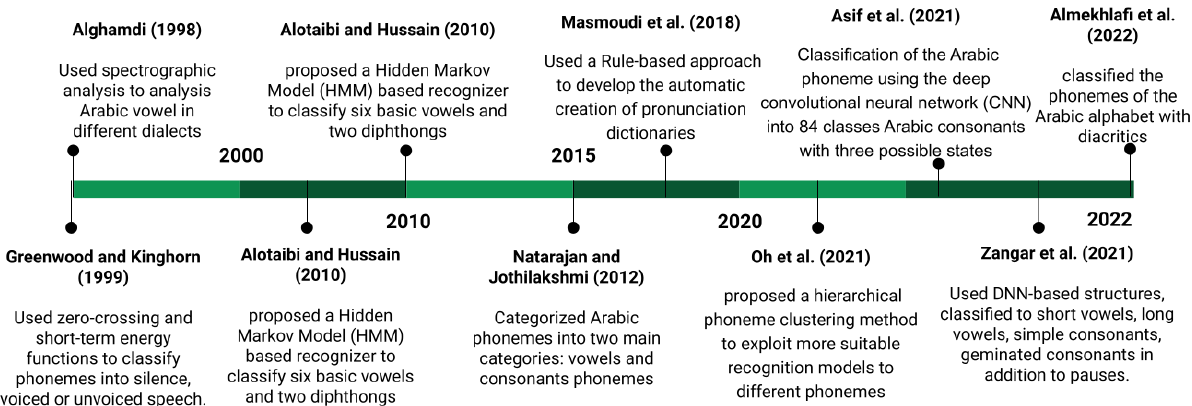
Figure 1. Chronology of the research related to Arabic phonemes classification.